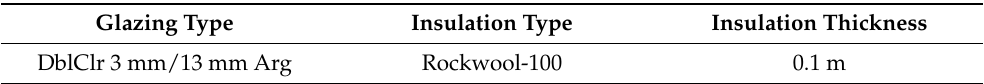
Table 4. The selected measures based on the present weather file.